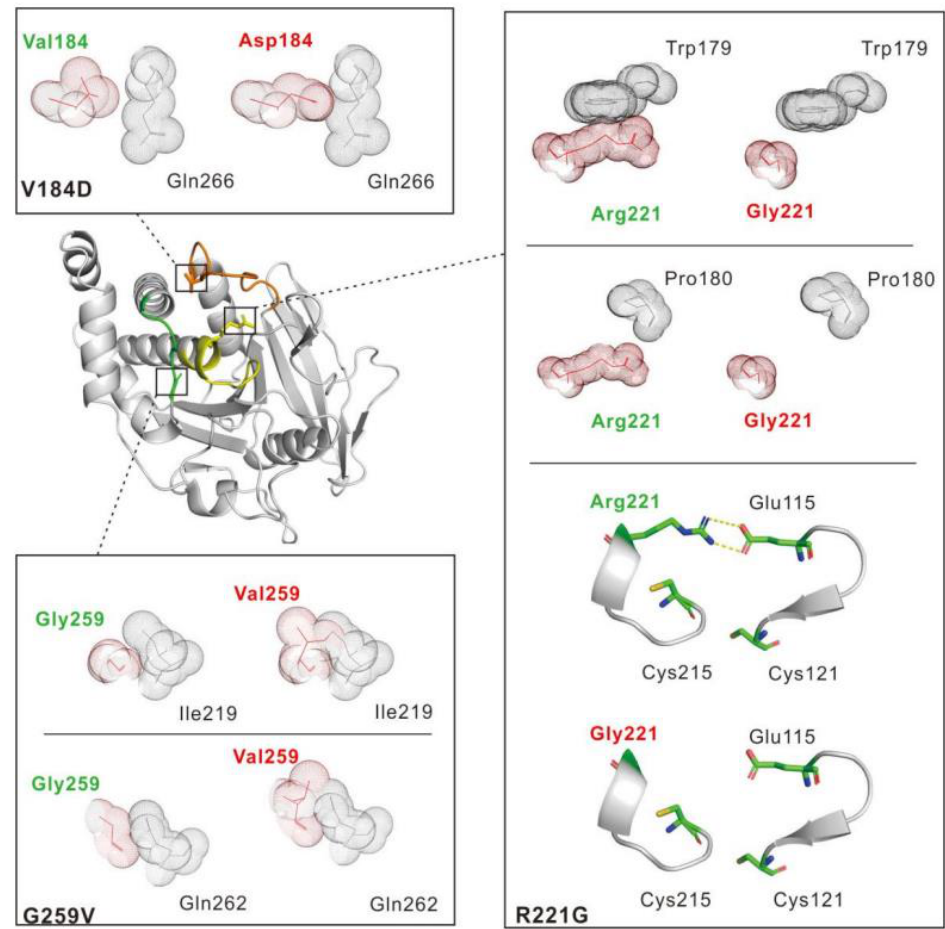
Figure 4. Impact of the V184D, R221G, and G259V mutations on the PTP1B structure. The PTP1B mutants were generated in silico using PyMol software (PTP1B PDB code: 2HNP). The positions of the mutations are shown in the PTP1B global structure. The WPD-Loop (residues 177 – 188), catalytic P-loop (residues 214 – 223), and Q-loop (residues 259 – 263) are shown in orange, yellow, and green, respectively. Close-up views of the V184D, R221G, and G259V mutations are displayed. Van der Waals radii are represented for each atom, and mutated residues are displayed in red. Salt bridges are depicted with yellow dashed lines.